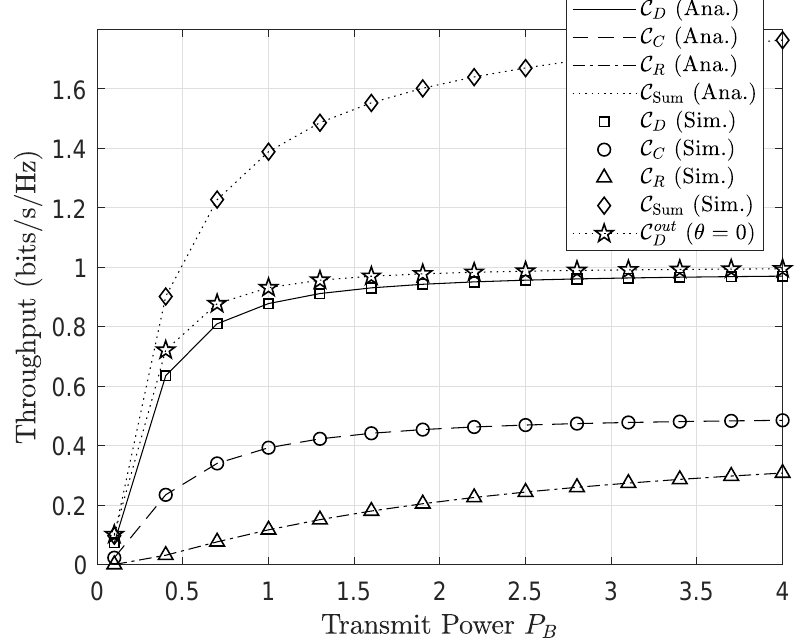
Figure 7. Throughput performance versus transmit power ( P B ) at the base